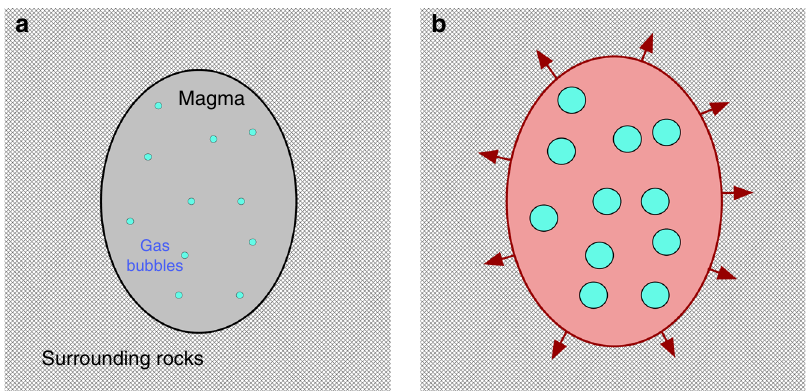
Fig. 1 Conceptual model of fl uid-related source of long-period earthquakes. a Bubble nucleation in a volume of magma saturated with H 2 O – CO 2 volatiles. b Bubble and pressure growth deforming the surrounding